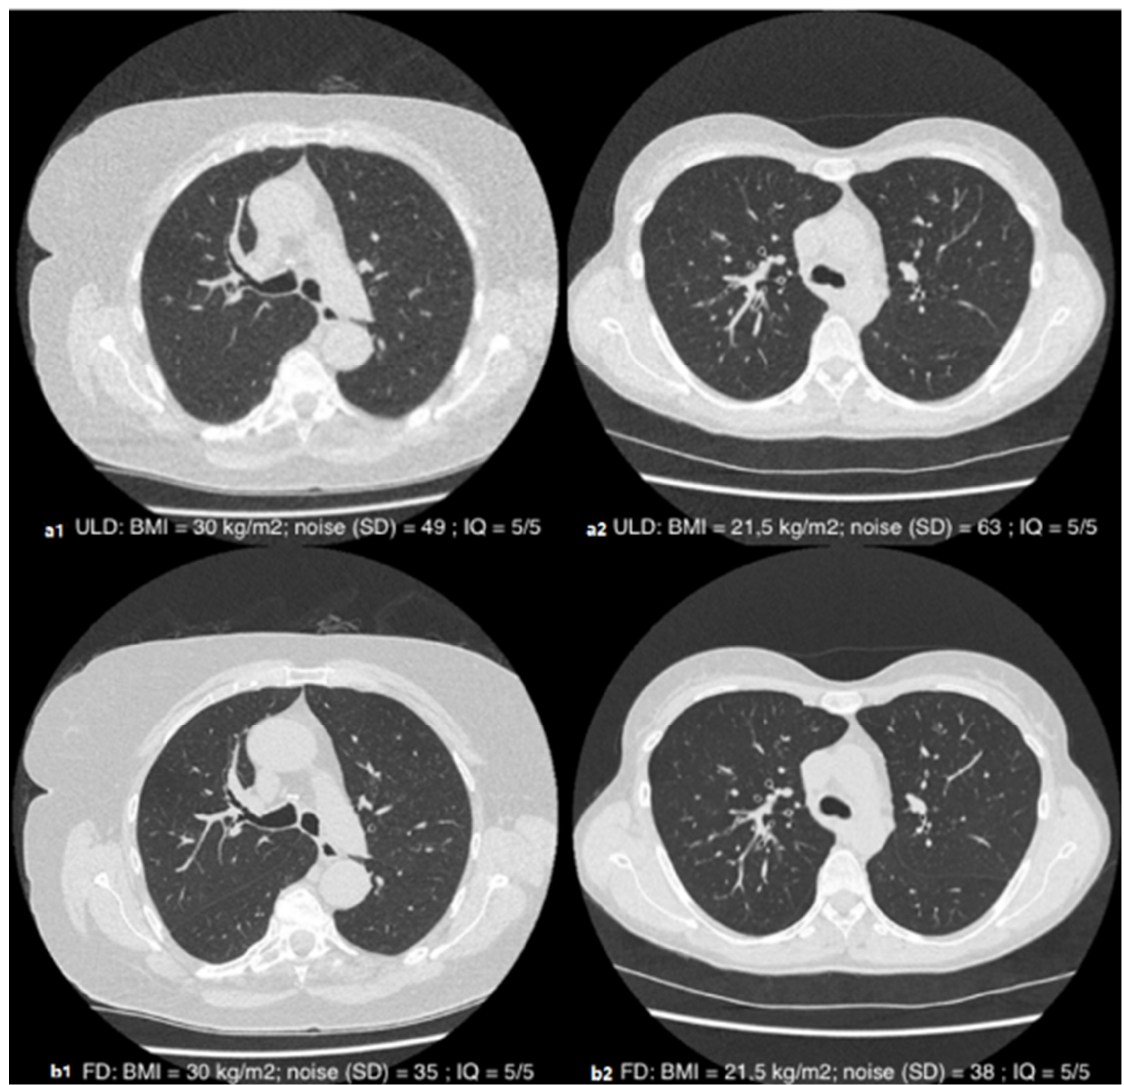
Figure 3. Axial slices in parenchymal window illustrating the subjective quality of the ULD ( a1 , a2 ) and FD ( b1 , b2 ) acquisitions in patients with a BMI of 30 kg·m − 2 (1) and 21.5 kg·m − 2 (2): diagnostic-quality images (QI = 5/5) despite the different morphotype.